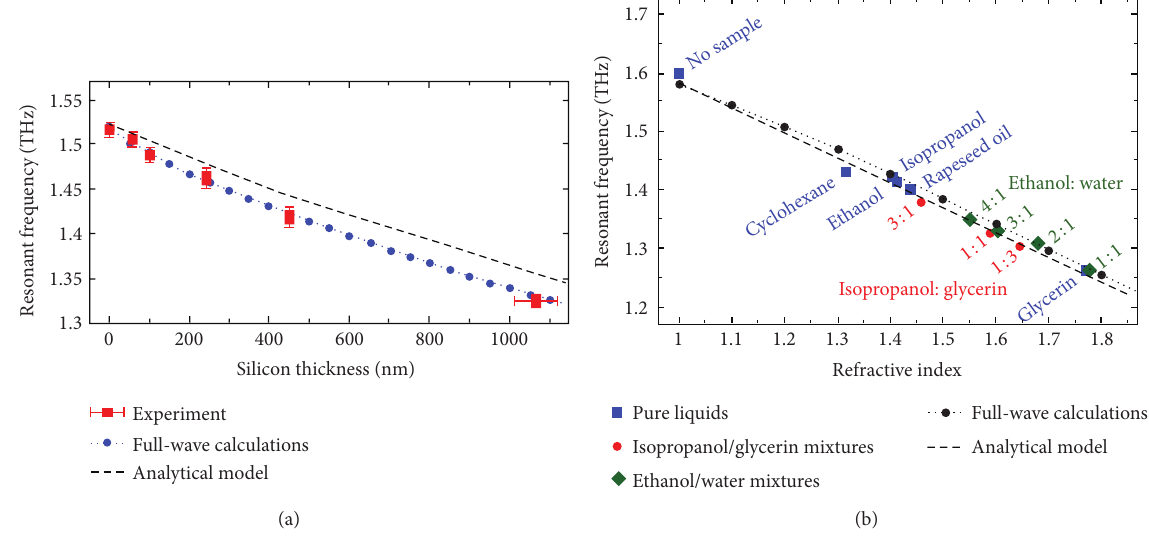
Figure 10: (a) Resonant frequencies of the sensor in dependence on silicon thickness. The slope of the curve has a maximum value of 0.4 THz/ 𝜇 m. (b) Experimentally measured Resonant frequencies of the metamaterial sensor in the presence of several liquids and liquid mixtures